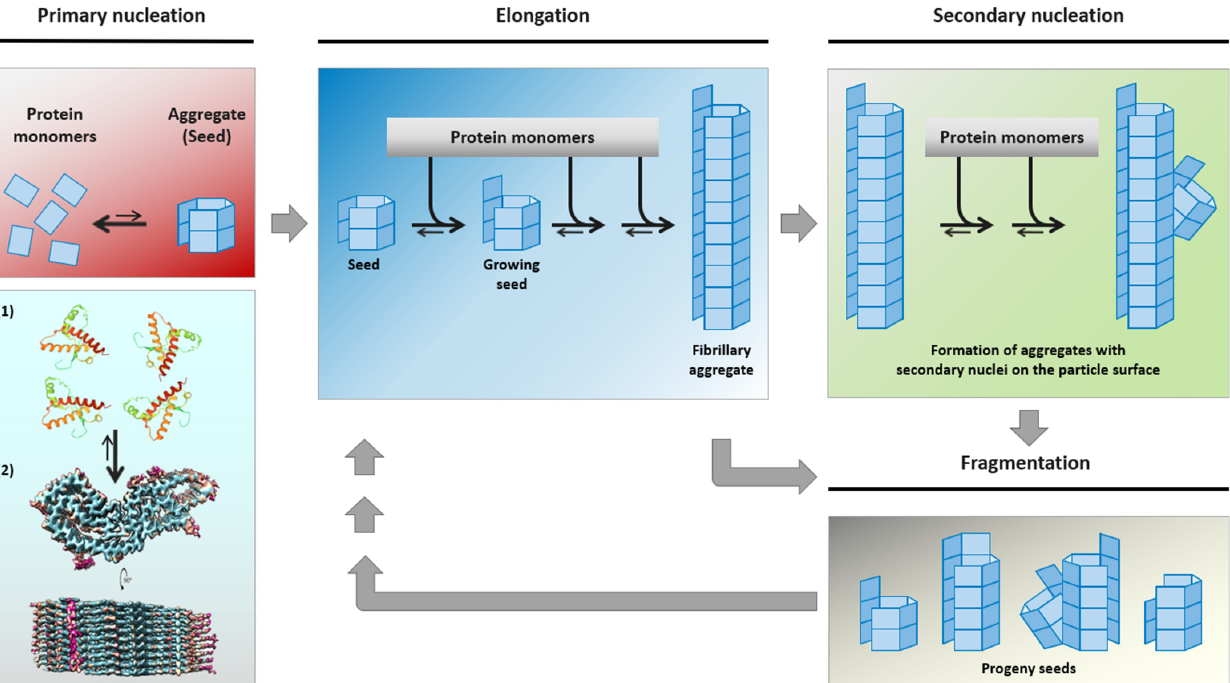
Figure 1. Mechanistic model of nucleation-dependent protein aggregation thought to underly the self-assembly and propagation of pathological α Syn PD , PrP TSE or other proteinaceous seeds in PD, TSE and further neurodegenerative protein aggregation diseases, respectively. Under certain conditions, (usually monomeric) protein conformers can spontaneously, or driven by genetic factors, assemble into β -sheet-rich aggregates that constitute self-replicative protein particles, or seeds. Such initial seed formation, referred to as primary nucleation, is controlled by a high kinetic barrier. Primary nucleation is exemplarily depicted for hamster PrP, schematically showing the aggregation of PrP monomers (1, [7]) into a PrP TSE seed (2, [8]). Once proteinaceous seeds have been endogenously formed, or exogenously entered the organism, they can swiftly recruit and attach further monomers of their constitutive proteins. In this process of elongation, new aggregate mass is generated by the attachment of monomeric species to the ends of the seeding-active particles. Additionally, secondary nucleation may occur by the formation of new nucleation sites on the particle surface. When protein particles with primary or secondary nucleation sites fragment into smaller aggregates, progeny seeds enter the replication cycle and further propagate the pathological protein state. The figure was produced, with modifications, following a previously published template [4] in consideration of Meisl et al. [9]. Credits for mounted image components: (1) https://www.rcsb.org/structure/4YXL (accessed on 16 July 2021): crystal structure of Syrian hamster prion protein complexed with POM1 FAB is licensed under the PDB Privacy and Usage Policy, and (2) https://www.biorxiv.org/content/10.1101/2021.02.14.431014v2 (accessed